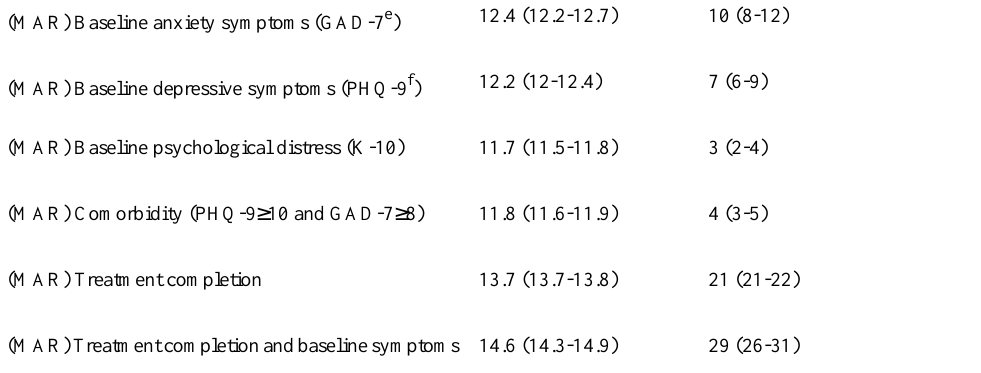
Models adjusted for predictors that form nonignorable missing cases mechanisms (missingness and K-10 d outcome